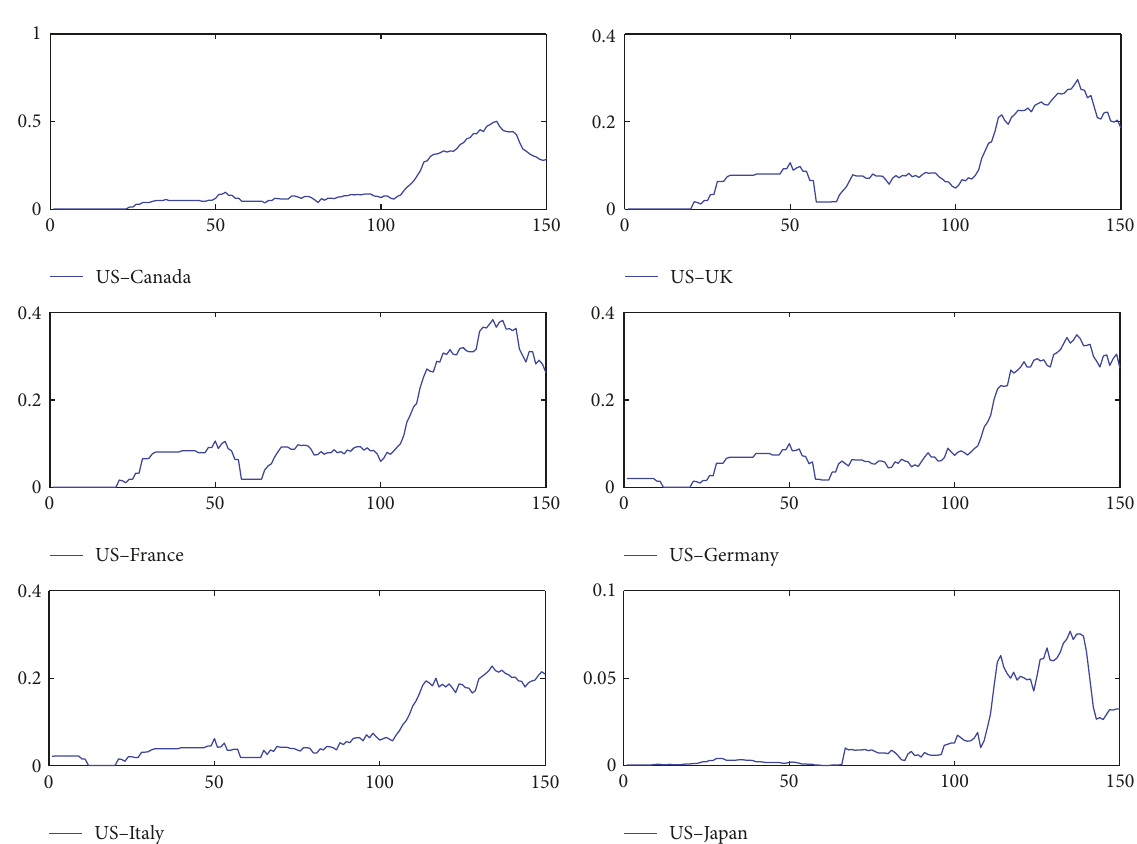
Figure 1: The evolution of the MI values between US and G7